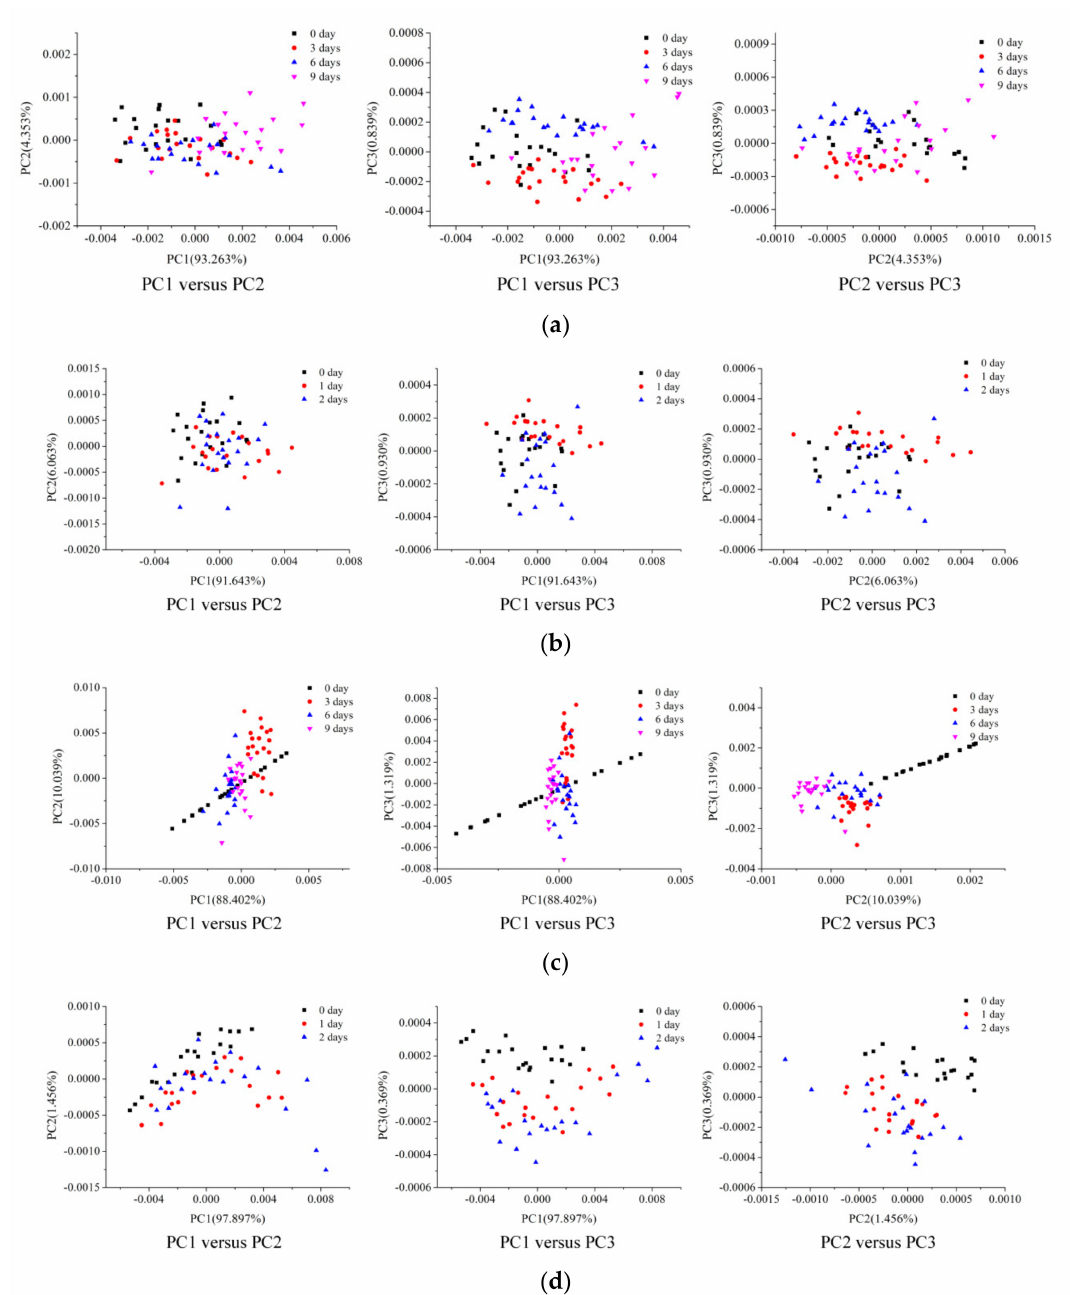
Figure 3. Score scatter plots of spinach leaves stored at ( a ) 4 ◦ C and ( b ) 20 ◦ C based on Vis-NIR hyperspectral data. Score scatter plots of spinach leaves stored at ( c ) 4 ◦ C and ( d ) 20 ◦ C based on NIR hyperspectral